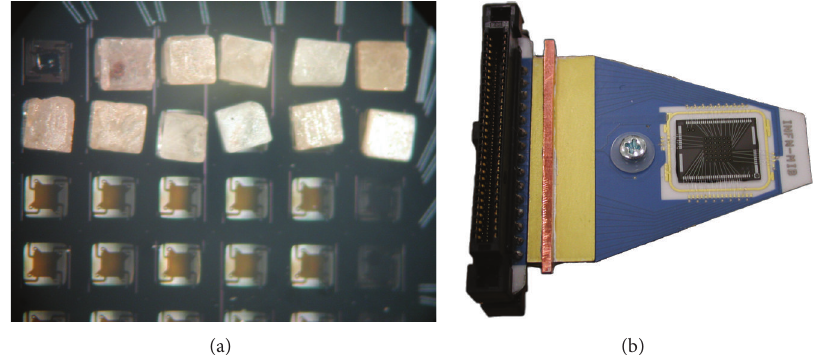
Figure 29: (a) AgReO 4 crystals glued to a 6 × 6 pixel XRS thermistor array. (b) View of the 6 × 6 array with readout lines (images courtesy of Nucciotti